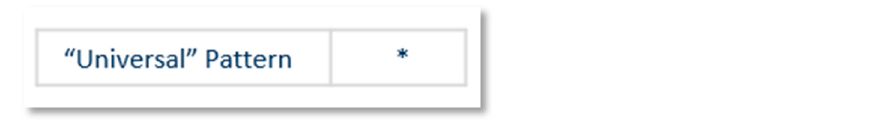
Figure 6. Universal Pattern. The Asterisk represents a wildcard token as described in Section 3.1.5.